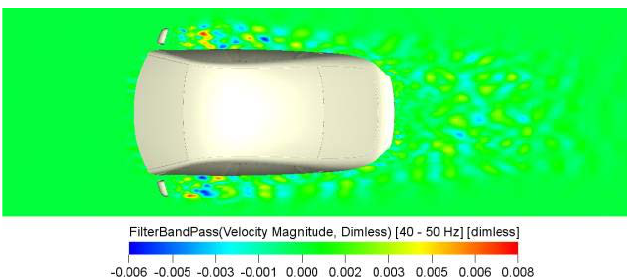
Figure 20. Velocity pulsation on horizontal section.